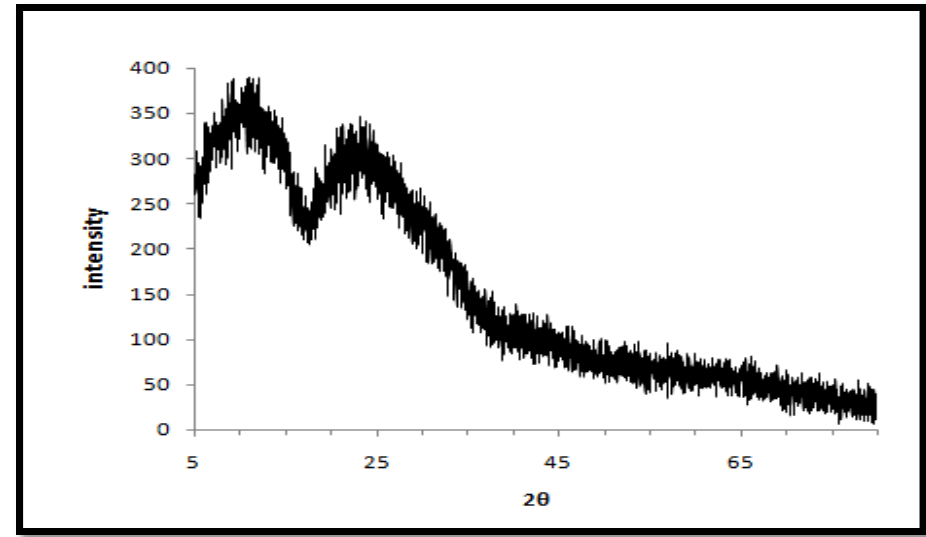
Fig.6: XRD pattern for polypyrrole film at 0.5 L/min argon gas flow